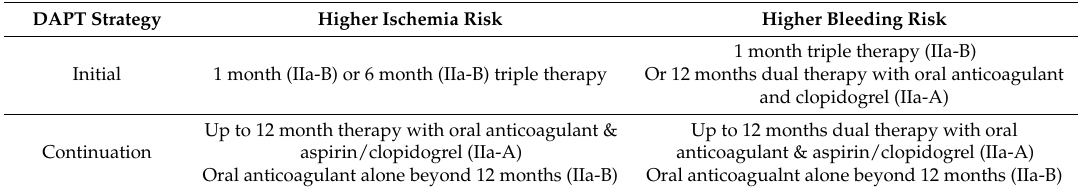
Table 9. Recommended therapeutic strategies for patients needing anticoagulation and anti-platelet therapy.